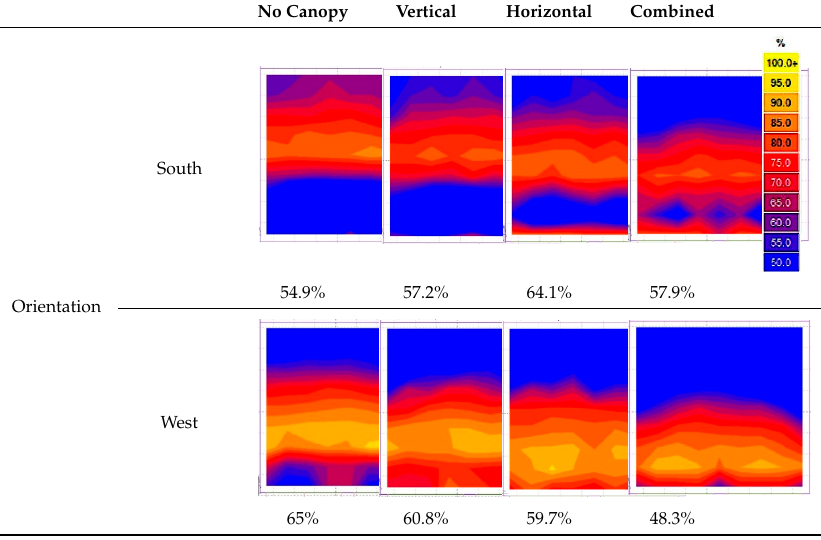
Table 6. Daylight Saturation Percentage (DSP) in the classroom with different shading devices.